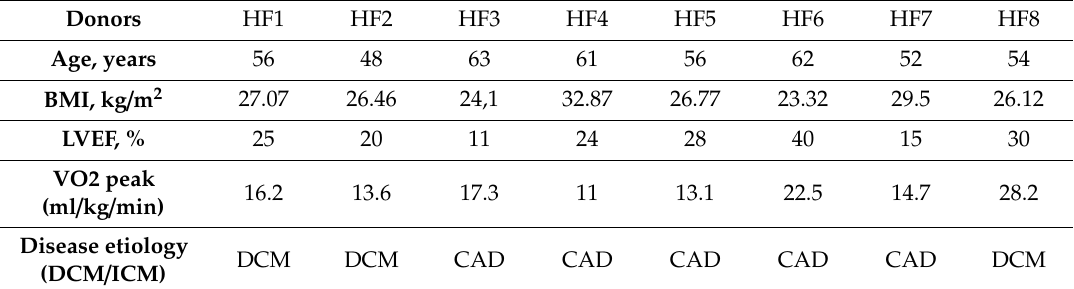
Table 2. Baseline characteristics of patients’ provided biopsy samples.